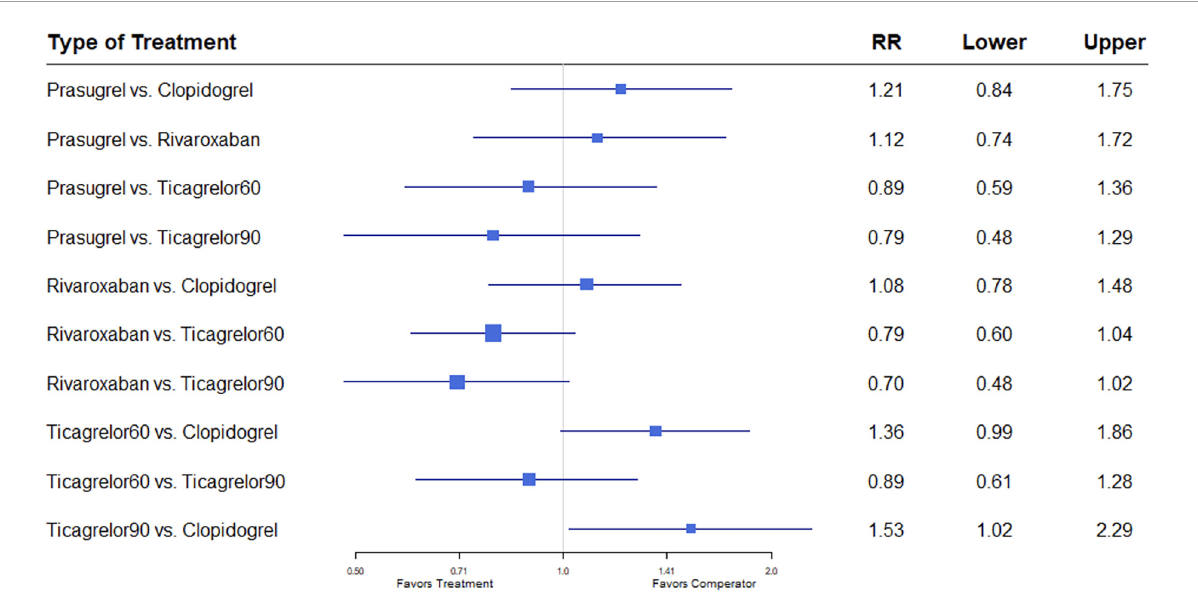
FIGURE7 A network meta-analysis of the association between anti-thrombotic therapy and major bleeding in patients with chronic coronary syndrome. Net-work Meta-analysis of the Association Between anti-thrombotic therapy and major bleeding.. The size of squares is proportional to the weight of each study. Horizontal lines indicate the 95% CI of each treatment; diamond, the pooled estimate with 95% CI; and RR, relative risk.